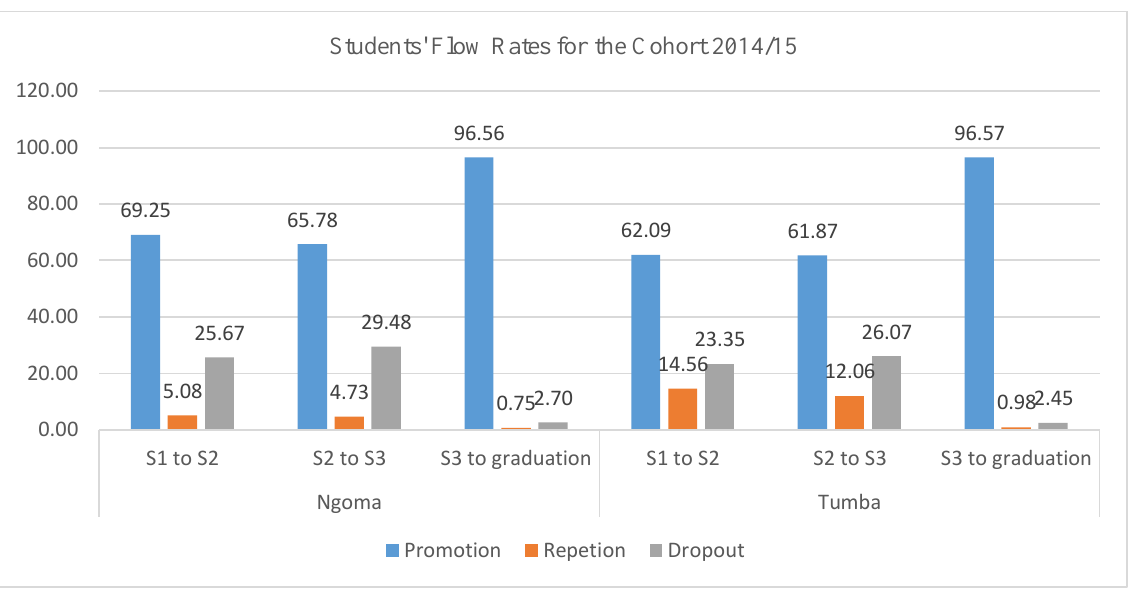
Figure 1: Students’ flow rates in Ngoma and Tumba Schools, Cohort